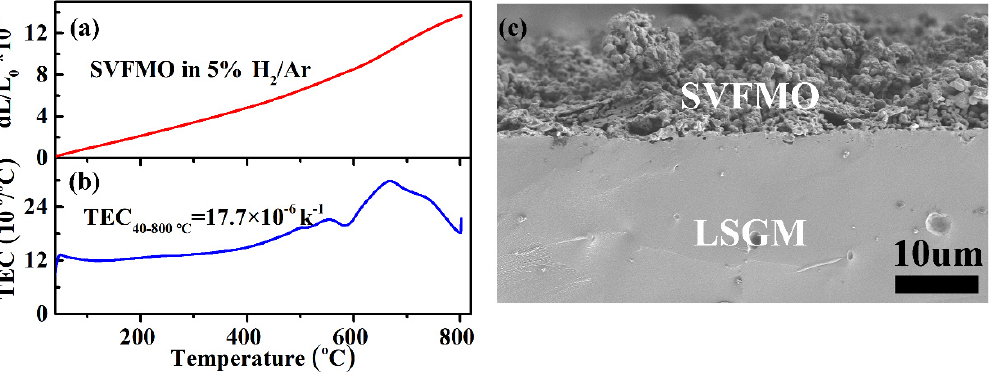
Figure 6. ( a , b )Thermal expansion curves and the calculated TEC for SVFMO dense bar testing between 40 − 800 °C in 5%H 2 /Ar; ( c ) the local SEM figure showing the good bonding of porous SVFMO electrode layer with dense LSGM electrolyte layer.